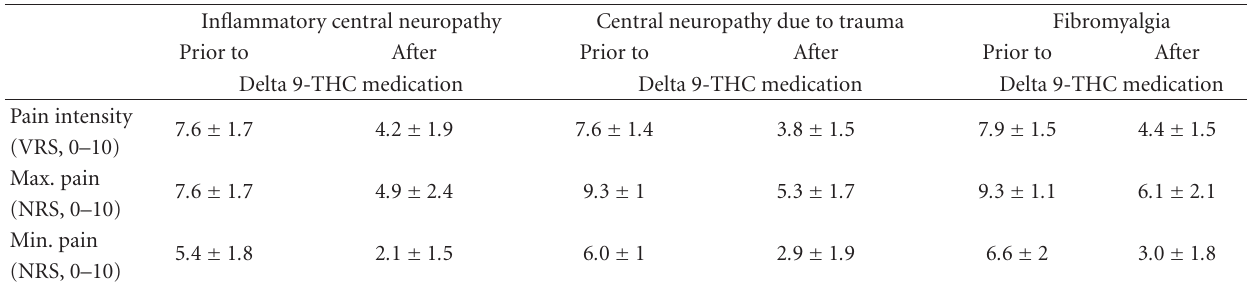
Table 3: Estimated pain intensity (VRS) and maximum/minimum pain (NRS) recorded in the subgroups of “inflammatory central di ff erences between the groups could be analysed. In each group, delta 9-THC medication caused a noticeable amelioration of